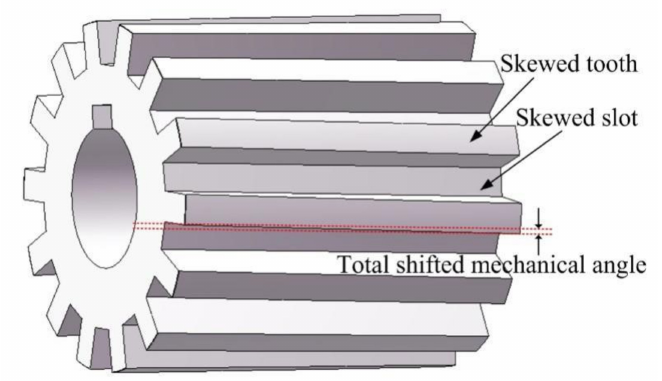
Figure 2. The continuous skewed slot structure of rotor core of the VFMPM machine. Table 1. The dimension parameters of the VFMPM machine.